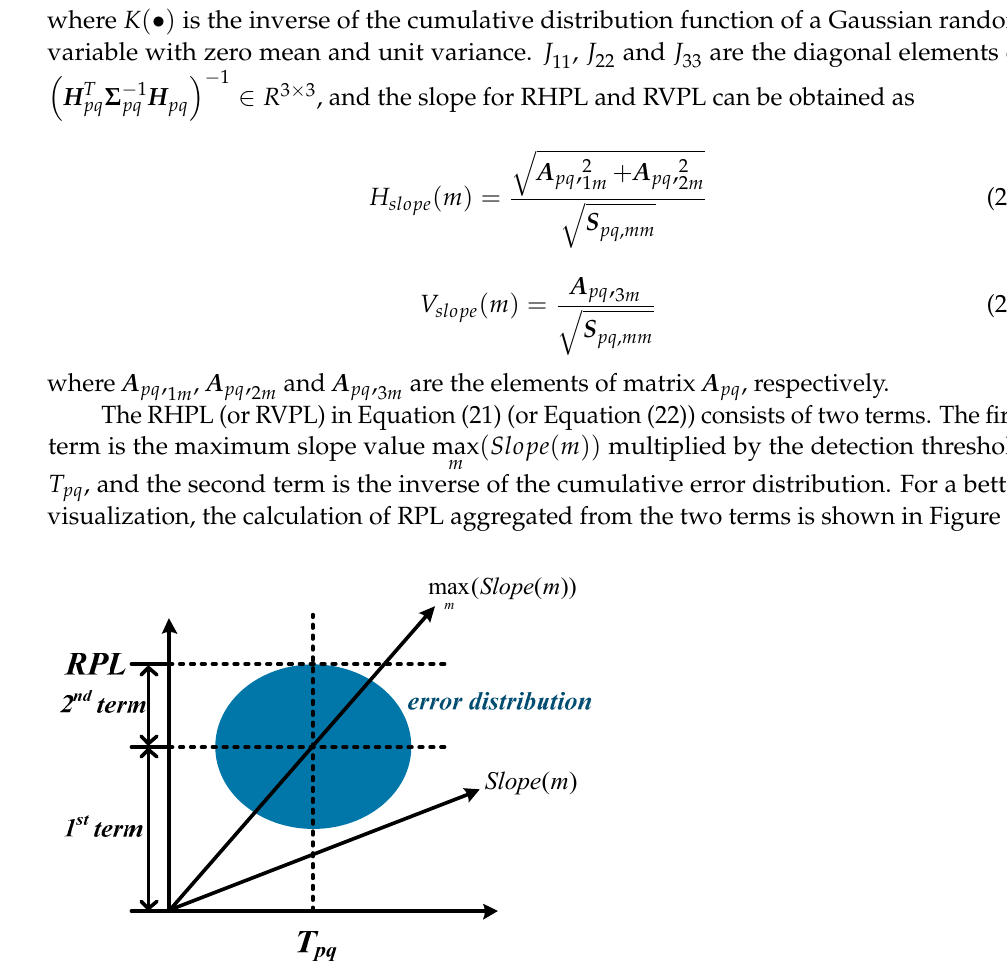
Figure 4. Calculation of relative protection level (RPL) aggregated from the maximum slope value ( Slope ( m )) multiplied by the detection threshold T pq (1st term) and the inverse of the cumulative error distribution (2nd term).